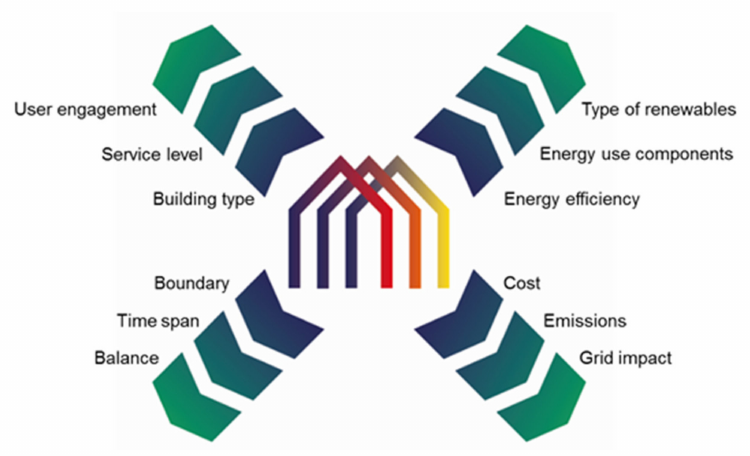
Figure 2. The central elements in the positive energy building definition presented in this article